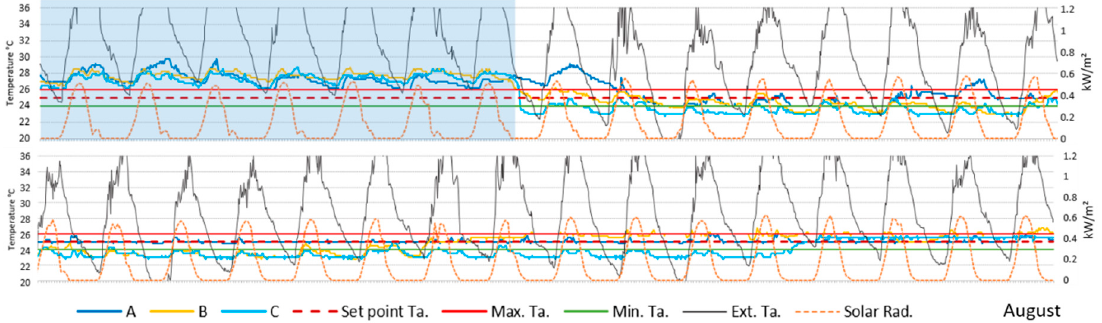
Figure 6. Monitored data collected for rooms during the selected week, July 25th to 31st.